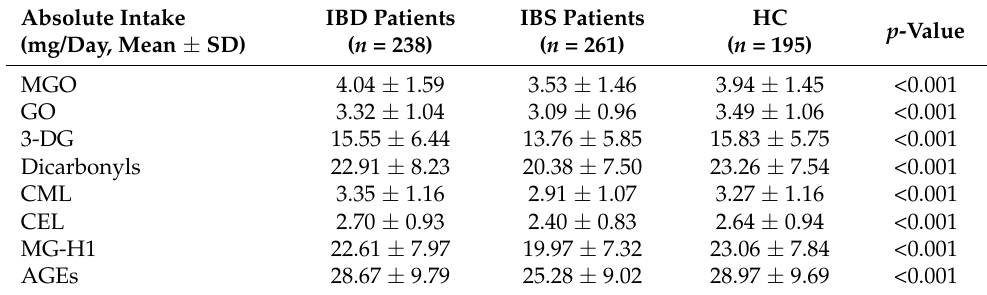
Table 2. Absolute dietary intake of individual dicarbonyls and advanced glycation